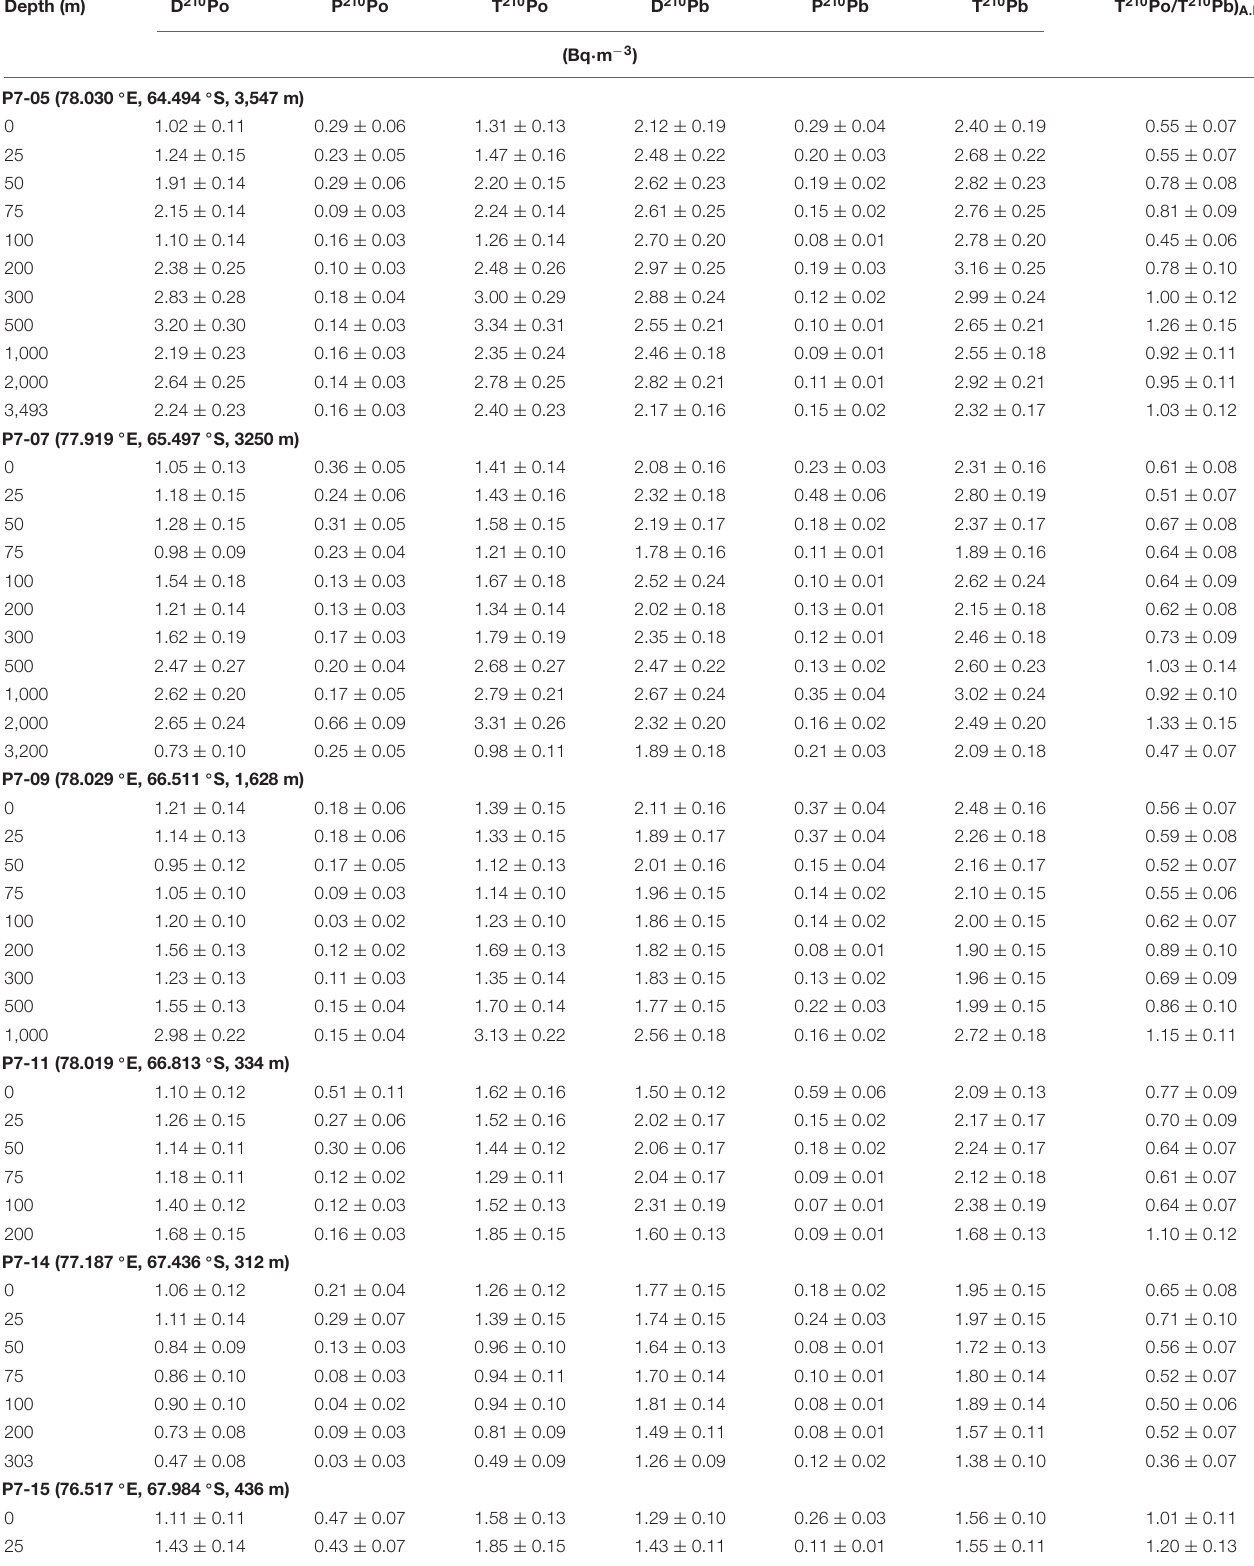
TABLE 1 | The activity concentration of dissolved and particulate 210 Po and 210 Pb, and the activity ratio of T 210 Po/T 210